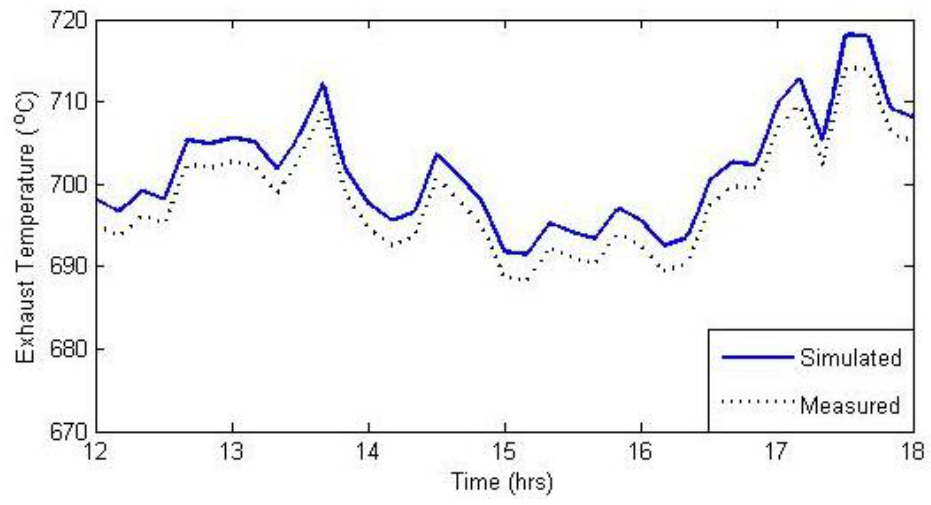
Figure 11. Plots of the simulated and the measured exhaust temperatures vs. time.